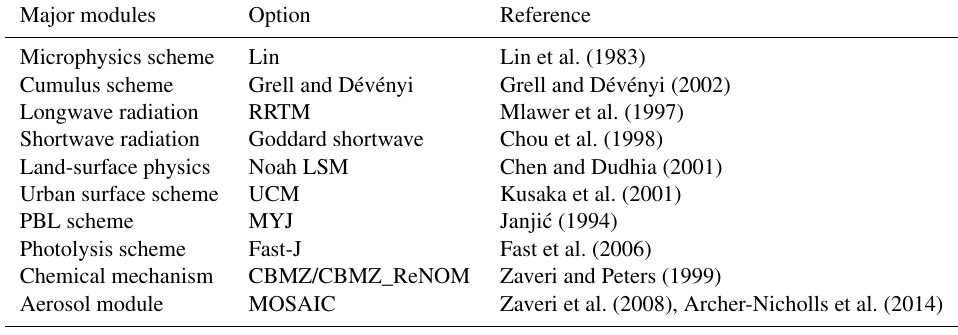
Table 2. WRF-Chem module configurations.